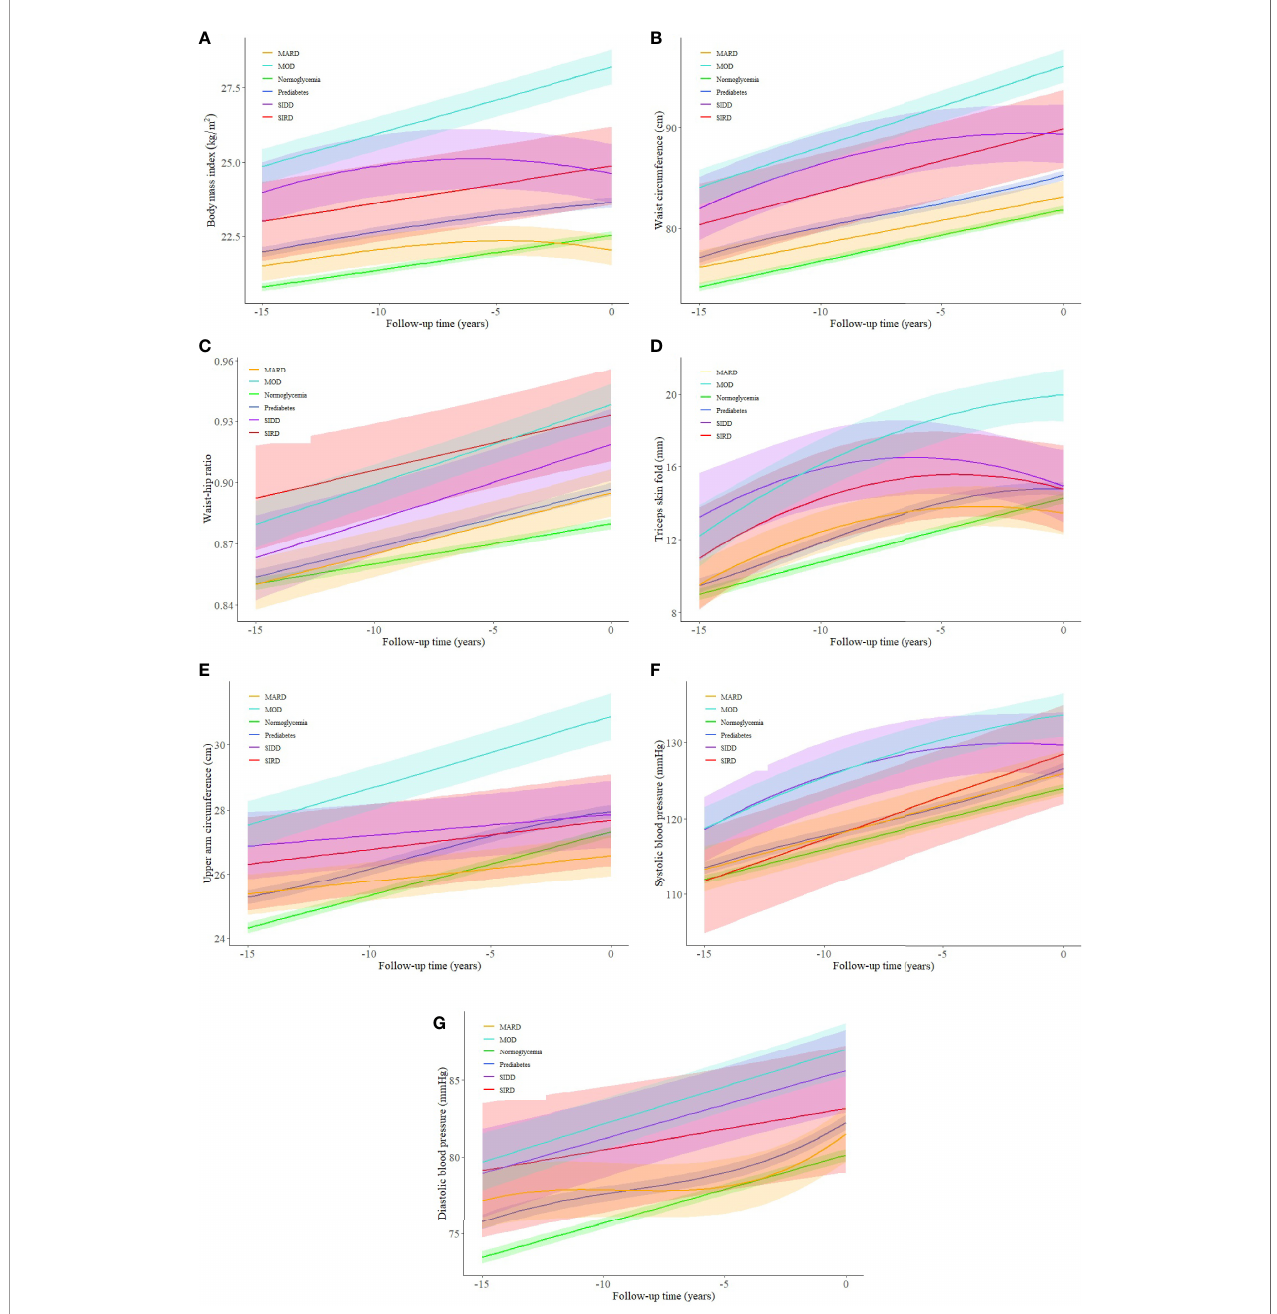
FIGURE 3 | (A – G) Trajectories of cardiovascular risk factors for a hypothetical 50-year-old man (in year 0) from 15 years before type 2 diabetes diagnosis among different glycemic statuses. SIRD, severe insulin-resistant diabetes; SIDD, severe insulin-de fi cient diabetes; MARD, mild age-related diabetes; MOD, mild obesity- related diabetes. The shaded areas represent the 95% con fi dent intervals around the